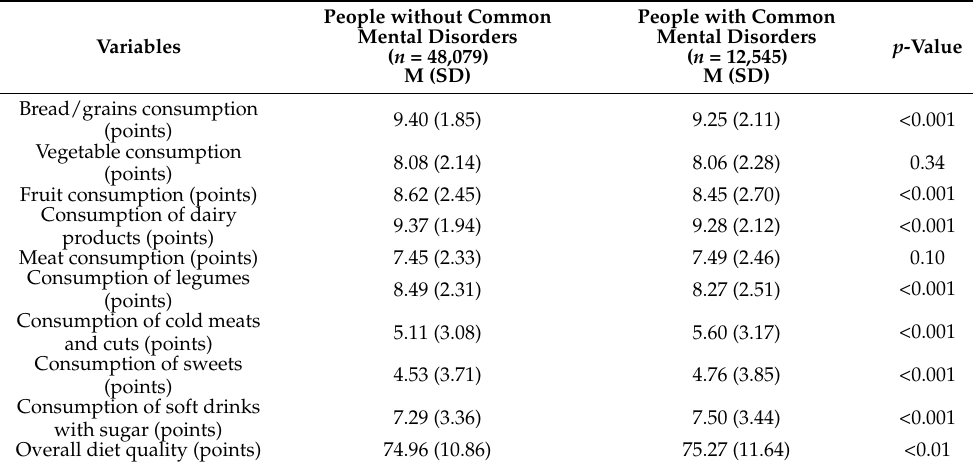
Table 3. Overall diet quality score and food groups’ scores according to mental status of